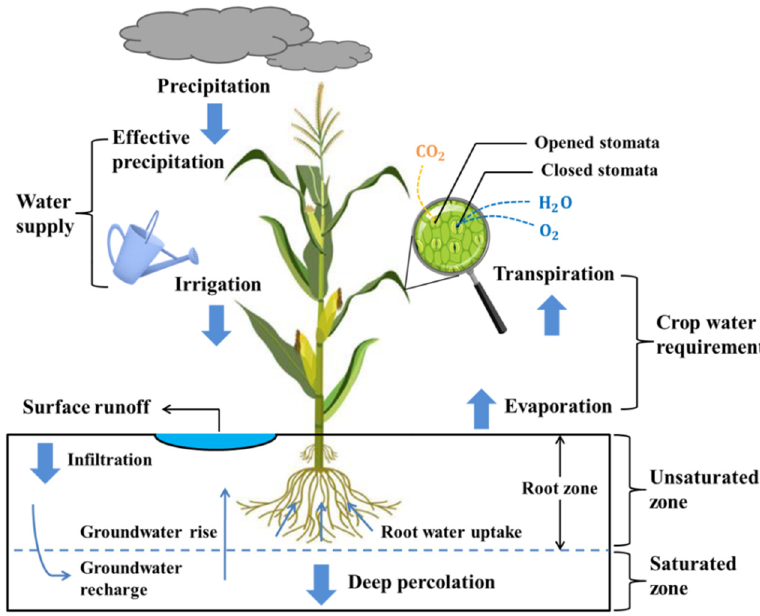
Figure 1. Maize water supply and demand balance processes.